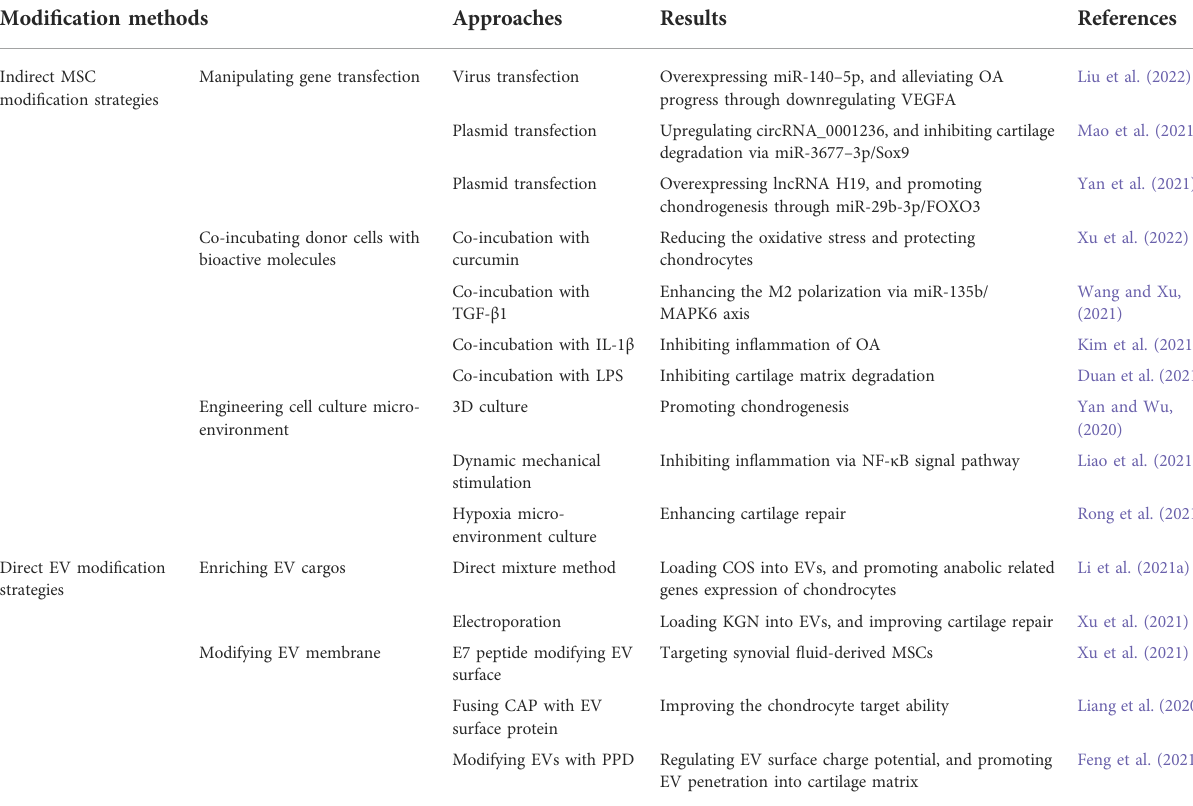
TABLE 2 Modi fi cation strategies for EV